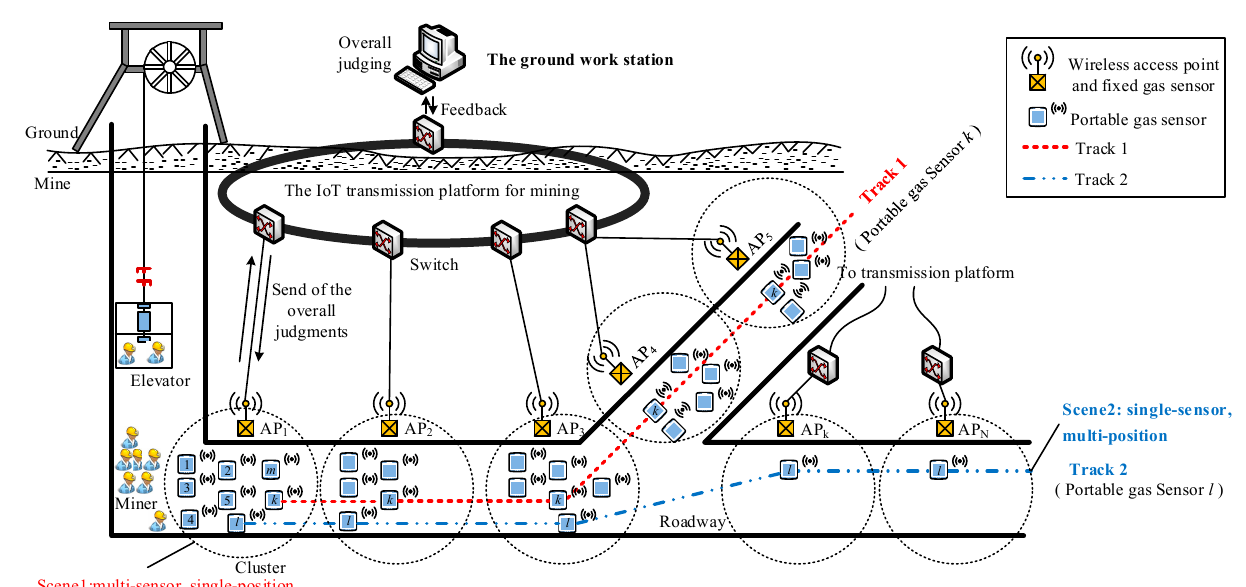
Figure 2. Network model of monitoring system.